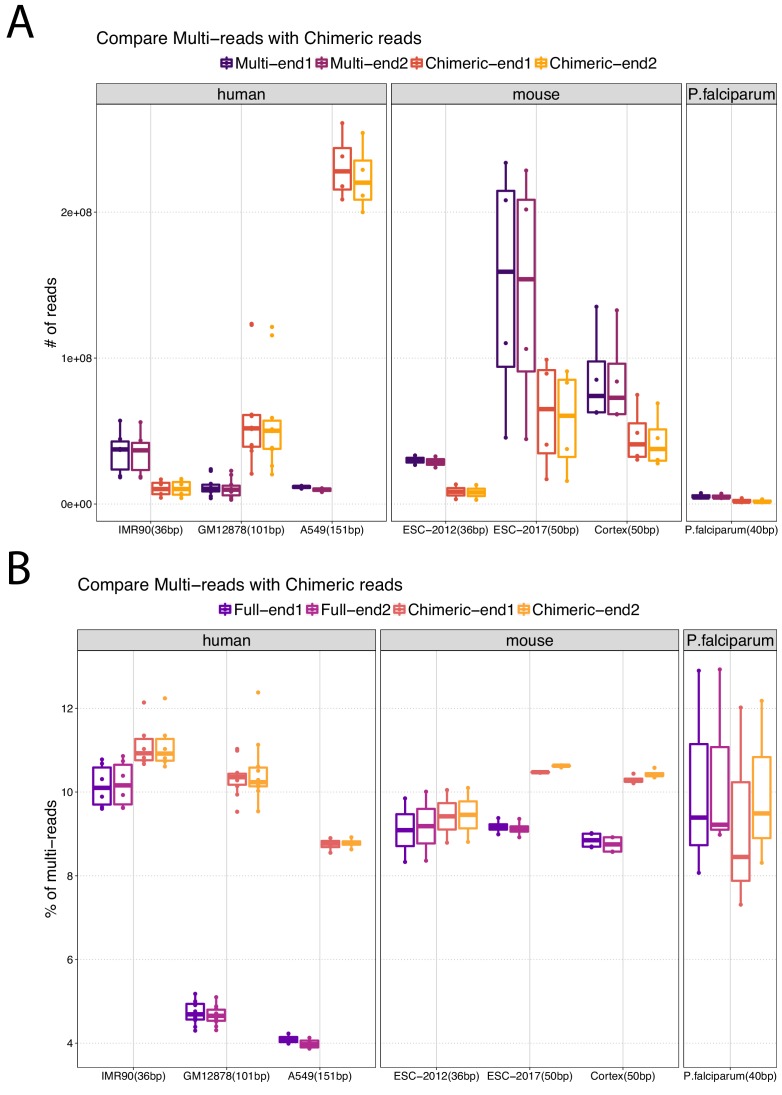
Comparison of the prevalence of multi-reads and chimeric reads, both of which require additional processing.(A) Numbers of multi-reads compared to the numbers of chimeric reads at each read end level. For Hi-C datasets with shorter read lengths, multi-reads constitute a larger percentage of the usable reads compared to chimeric reads. (B) Proportion of multi-reads among full-length alignable reads compared with that among chimeric reads. As expected, chimeric reads lead to larger percentages of multi-reads.